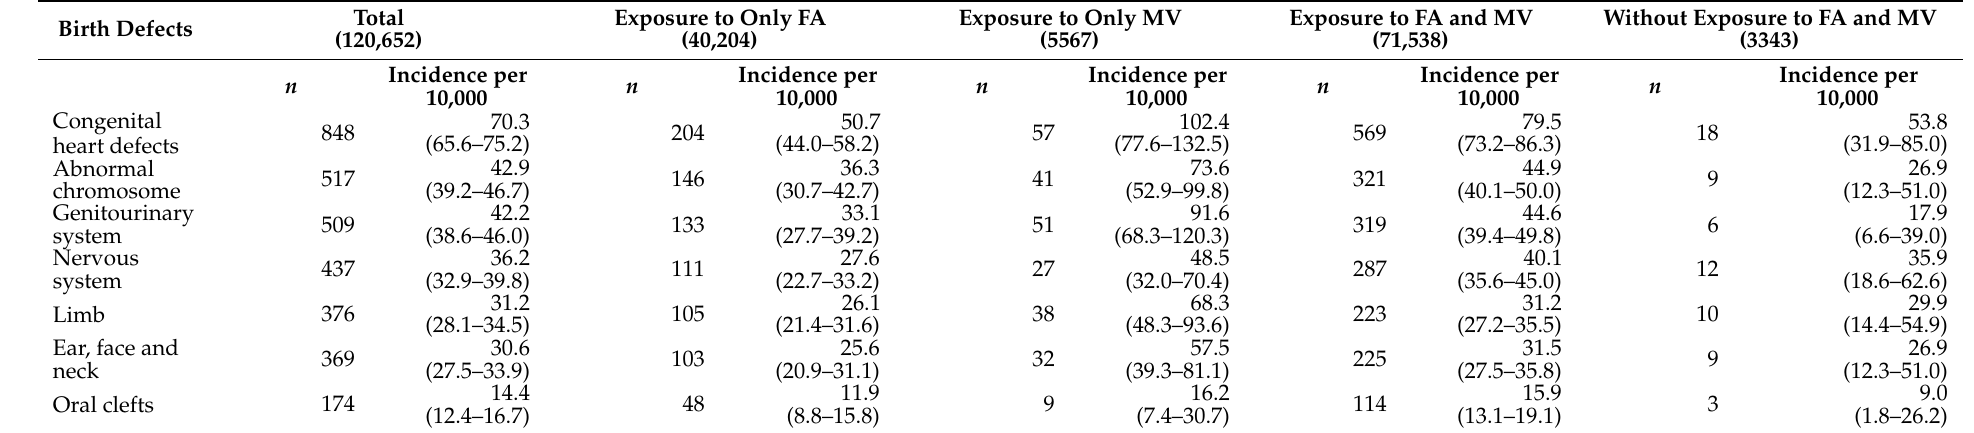
Table 2. Incidence and its 95% confidence interval of major birth defects in different exposure group.